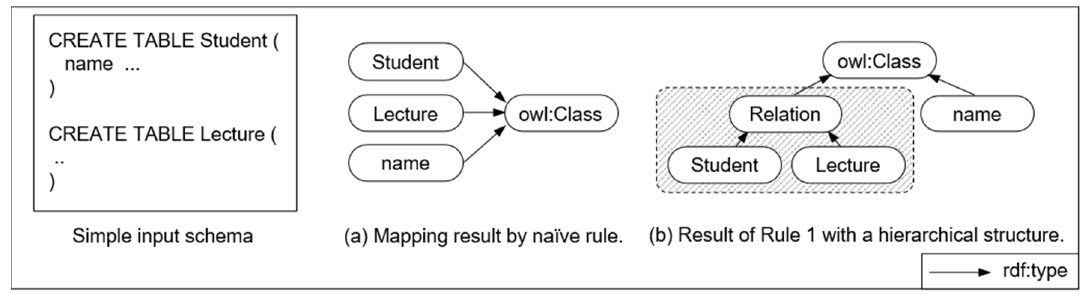
Figure 10. A comparative example of rules for mapping relational tables (Rule 1).